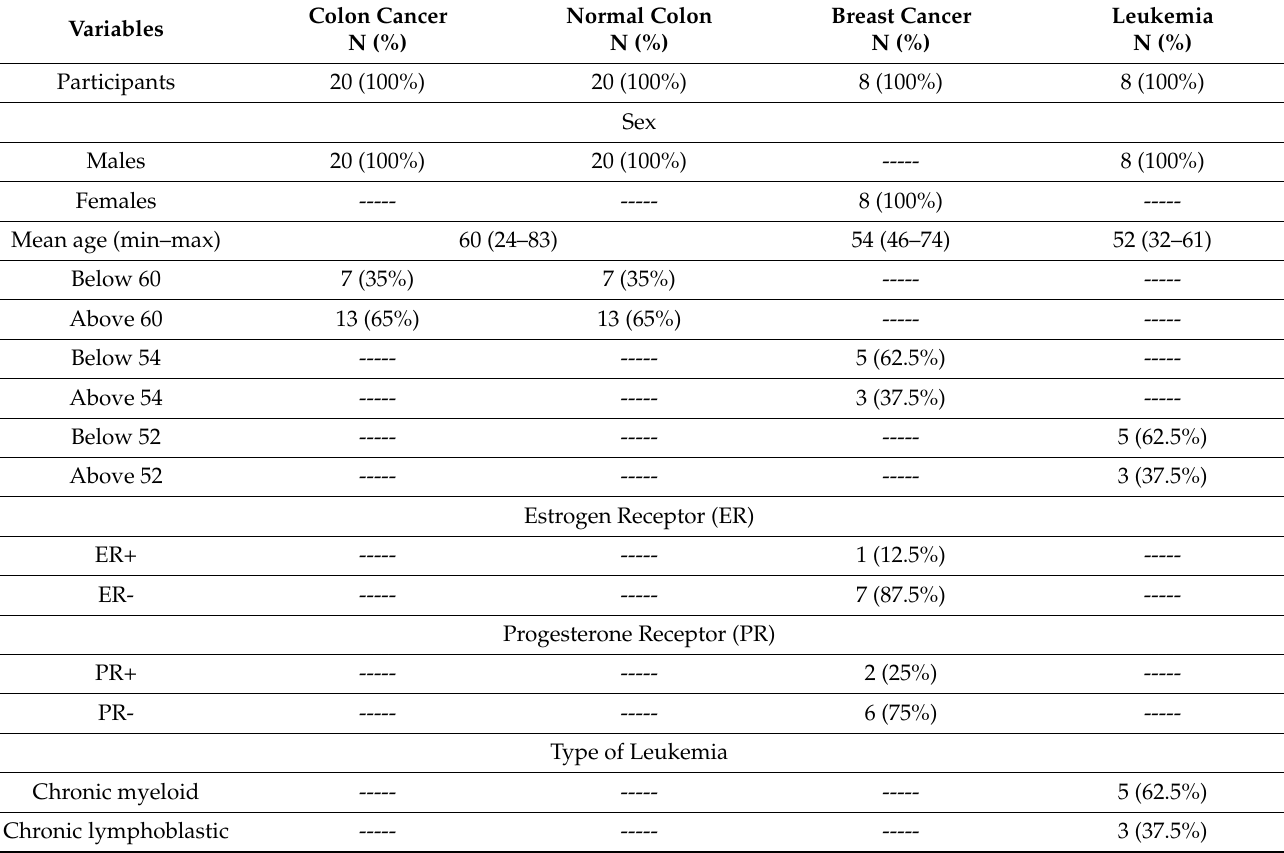
Table 3. General clinical parameters of the study participants.